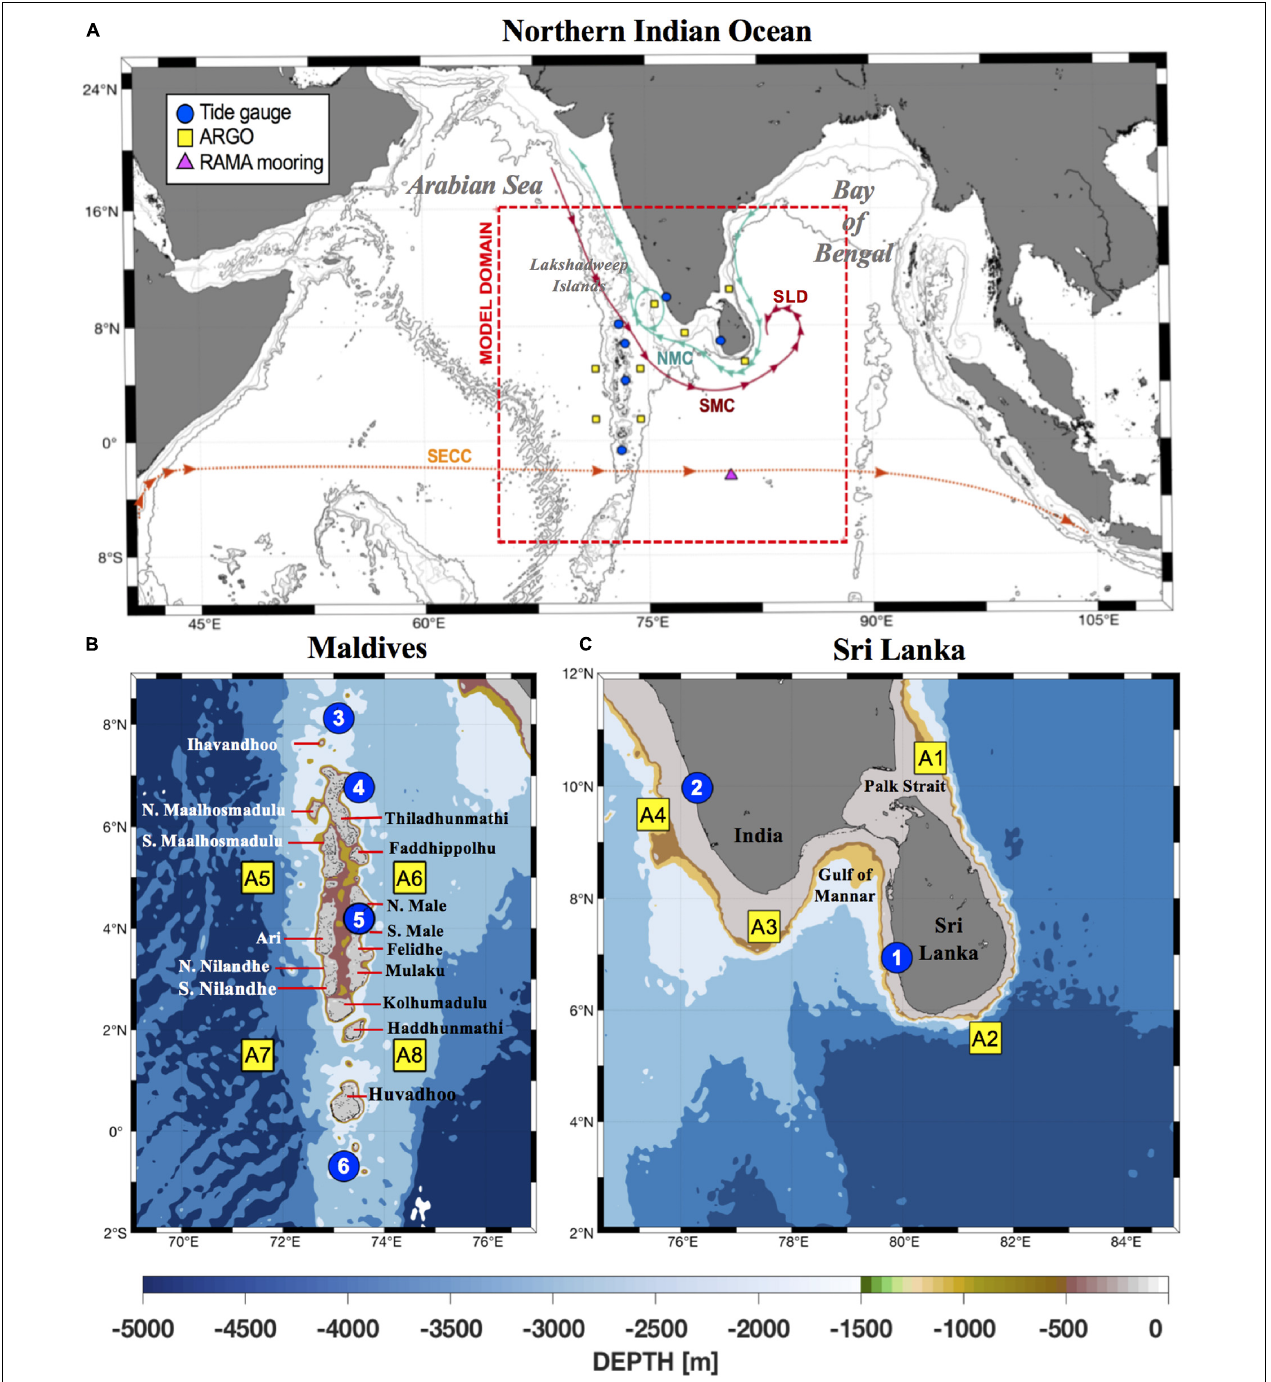
FIGURE 1 | (A) Schematics for the surface circulation in the Northern Indian Ocean (NIO) adapted from Schott and McCreary, 2001. The major currents during the Northeast Monsoon (Dec–Feb) and the Southwest Monsoon (Jun–Aug) are the Northeast Monsoon Current (NMC—green line), the Southwest Monsoon Current (SMC—red line), and the Sri Lanka Dome (SLD), respectively. Also included is the South Equatorial Counter Current (SECC—orange line). The red box represents the boundaries of the model domain. The locations of ARGO profile data (yellow boxes), tide gauges (blue circles), and mooring (pink triangle) used for model validation are also identified. (B) Bathymetry map of the Maldives and atoll names. Tide gauge sites are (3) Minicoy, India (4) Male, Maldives (5) Hanimaadho, Maldives (6) Gan, Maldives based on data obtained from the University of Hawaii Sea Level Center (UHSLC—https://uhslc.soest.hawaii.edu/). Locations for ARGO profile data extraction (A5–A8) were selected based on data availability and where the IME has been previously identified from remote sensing data. (C) Bathymetry map of India and Sri Lanka. Tide gauge sites are (1) Colombo, Sri Lanka and (2) Cochin, India. Locations for ARGO profile data extraction (A1–A4) were selected to coincide with the main pathways of the monsoon currents, NMC and SMC and where the IME has been previously identified from remote sensing data.